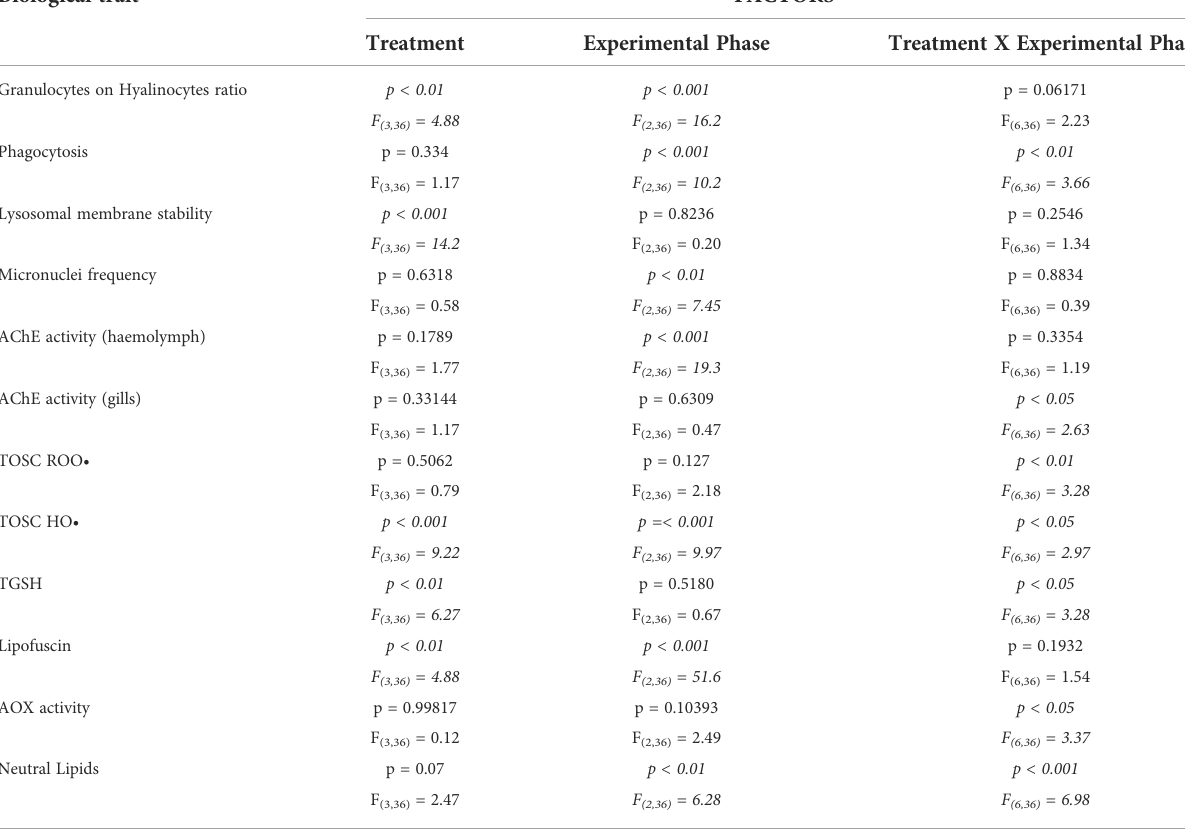
TABLE 1 Two-way ANOVA results for single factors (Treatment, Experimental Phase) and their interactions; F-values with degrees of freedom and p-values are reported for each factor and interaction for each analyzed biological trait. Biological